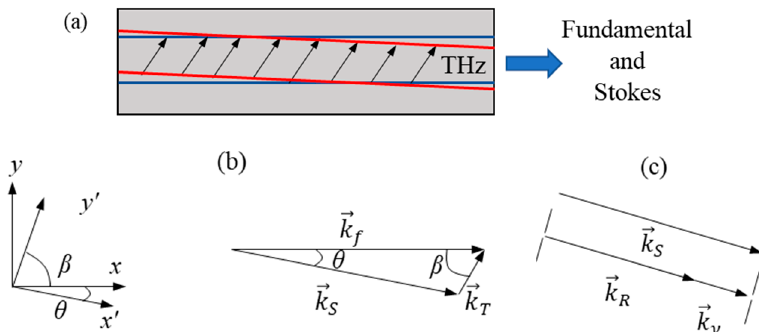
Figure 4. ( a ) Interaction area of the SPS process, ( b ) Noncollinear phase-matching in the SPS process, ( c ) Collinear SRS process.